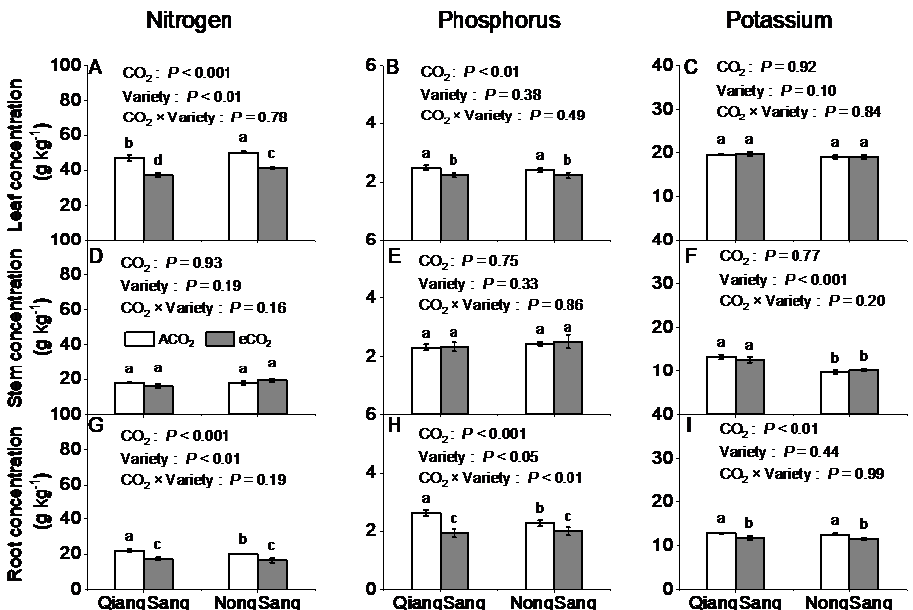
Figure 3. Concentrations of nitrogen ( A , D , G ), phosphorus ( B , E , H ) and potassium ( C , F , I ) in leaves, stems and roots of two mulberry varieties ( Morus multicaulis Perr. var. QiangSang and NongSang) grown under ambient CO 2 (ACO 2 , 410/460 ppm, daytime/nighttime) and elevated CO 2 (eCO 2 , 710/760 ppm) levels. Data (means ± SE, n = 3) followed by different letters indicate significant differences ( p < 0.05) as revealed by Tukey’s test. Statistical comparisons (two-way ANOVA) between varieties and CO 2 treatments as well as their interaction (CO 2 × variety) are presented for each variable.